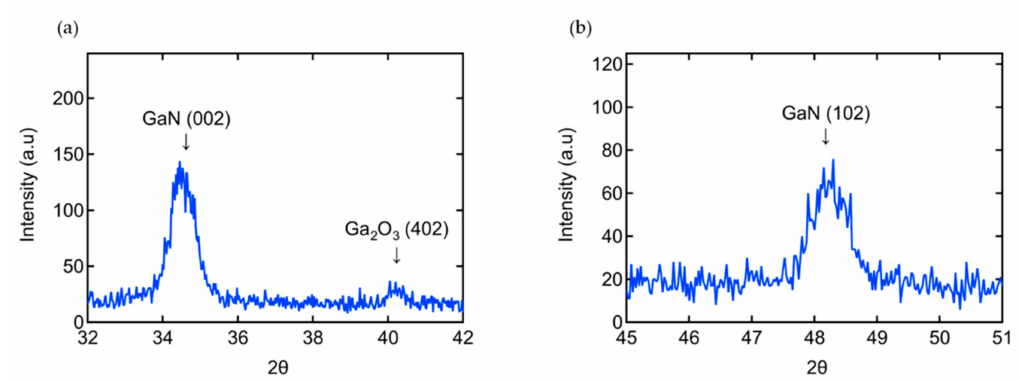
Figure 4. High-resolution x-ray di ff raction (XRD) of 13 nm GaN thin films on Si (100) of ( a ) the GaN (002) peak and a small β -Ga 2 O 3 peak and ( b ) the GaN (102)